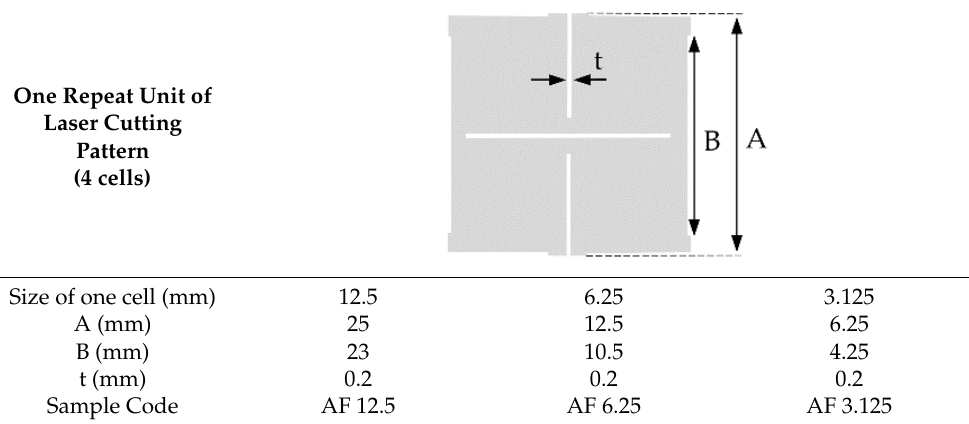
Figure 1. Deformation of fabric with rotating square unit cells geometry under loading (dashed lines–the initial size of the specimen) with particles of different sizes going through the fabric’s open area depending on the applied tension force (a and b are rhombus diagonals). Three rotating square unit cell sizes were studied in this research, i.e., 12.5 mm × 12.5 mm, 6.25 mm × 6.25 mm, and 3.125 mm × 3.125 mm. The hinge sizes and slit thicknesses remained the same for all tested samples. The details of the applied rotating square unit cell geometry are given in Table 2. The geometry of rotating cells refers to a network of rigid squares. One repeat unit of rotating cells is formed of four squares connected with the 2 mm long hinges at their corners with neighbourhood squares. Slit thicknesses between the rotating squares was 0.2 mm. Applied tensile force in the longitudinal direction causes these squares to rotate around hinges relative to each other, and consequently, the open and hence auxetic behavior is achieved. Table 2. The geometry of the laser cutting pattern and rotating cells.